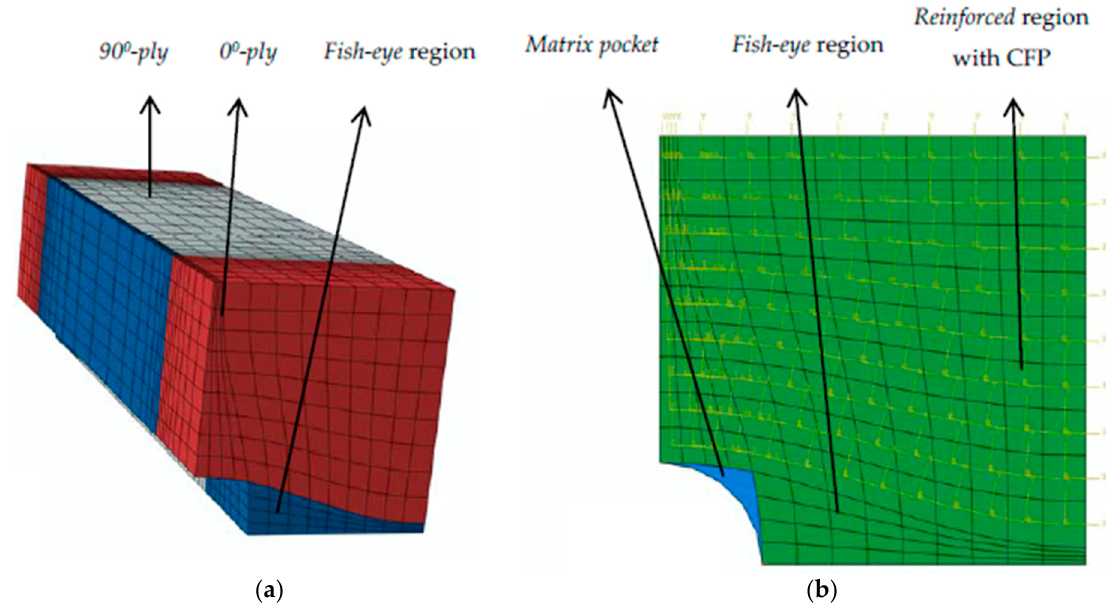
Figure 7. Here ( a ) represents the 3D micro model comprising of [0/90]s laminate and ( b ) represents the front view of the 3D model, indicating the orientations as well as the matrix pocket, fish-eye and reinforced region.